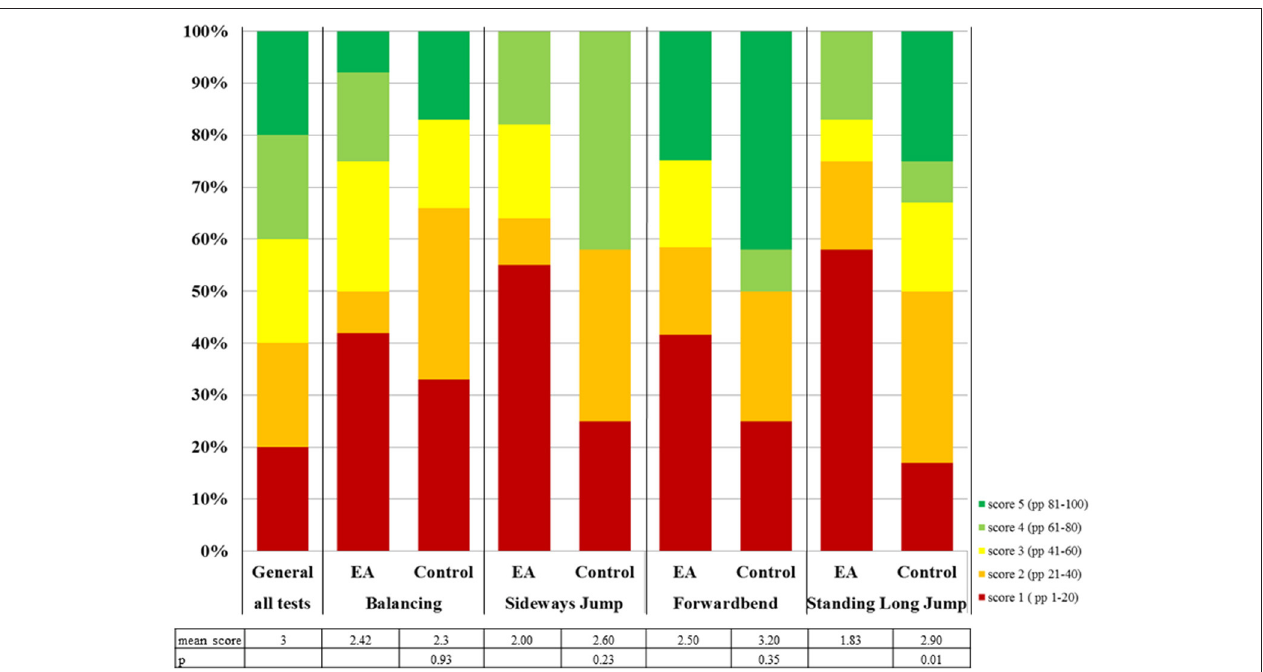
FIGURE 1 | Distribution of locomotor test scores of children with EA compared to the general population and control group. The distribution of test results for the general population is the same for every test item. PP = performance